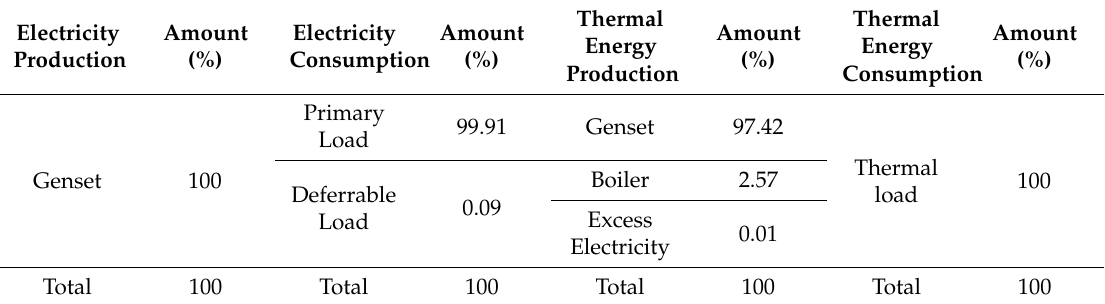
Table 9. Energy production and consumption scenario of off-grid mode for the first year of project life (case-01).